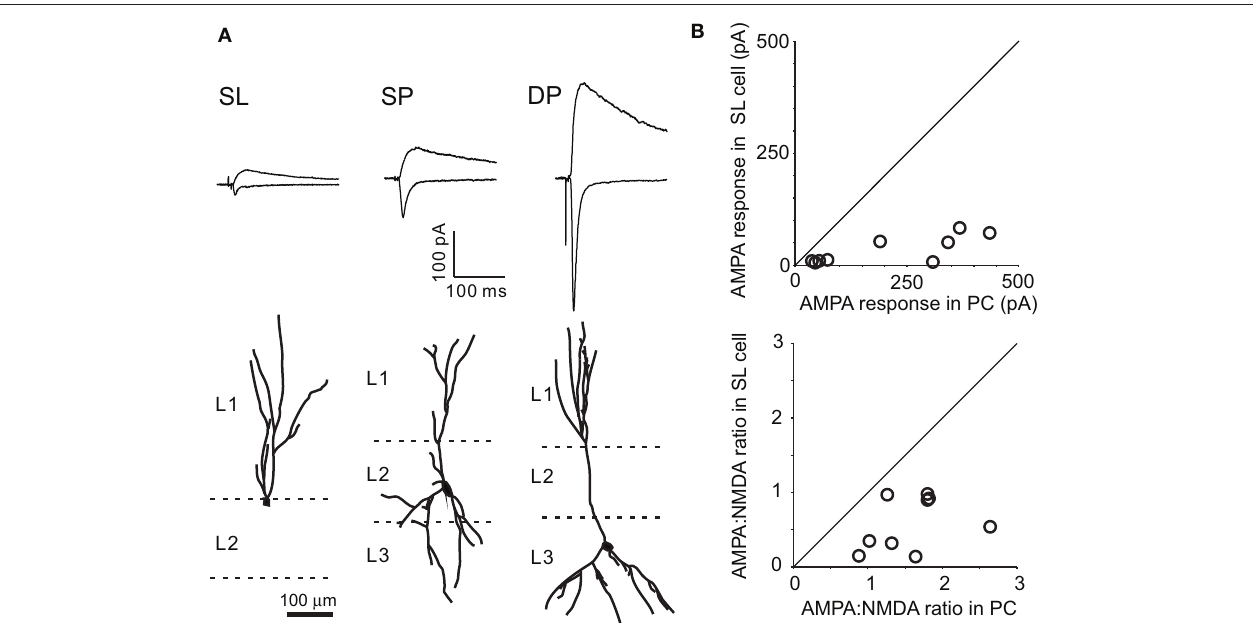
FIGURE 3 | Properties of monosynaptic input from the AON to aPC. (A) Monosynaptic inputs to three types of principal neurons in the aPC. Light evoked monosynaptic EPSCs in SP, superficial pyramidal; DP, deep pyramidal; and SL, semilunar cells. Images show representative examples of each cell type filled with biocytin, indicating the location of the cell body and the extent of apical and basal dendrites (bottom). (B) Comparison of AMPA responses this class can possess basal dendrites (Wiegand et al.,